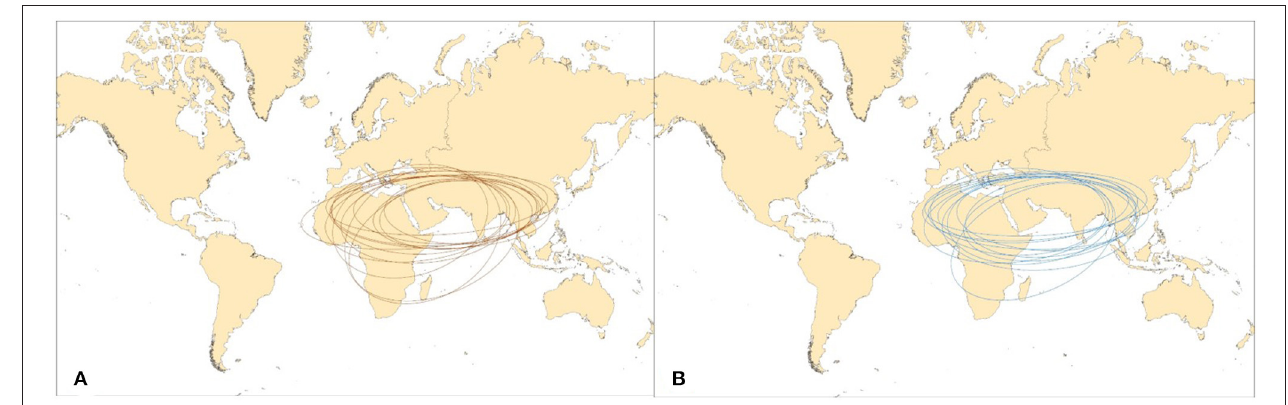
FIGURE 3 | Annual Standard Deviational Ellipses (SDE) derived on the geographic location of conflicts each year from 1989 to 2014 (A) El Niño years; (B) La Niña years.